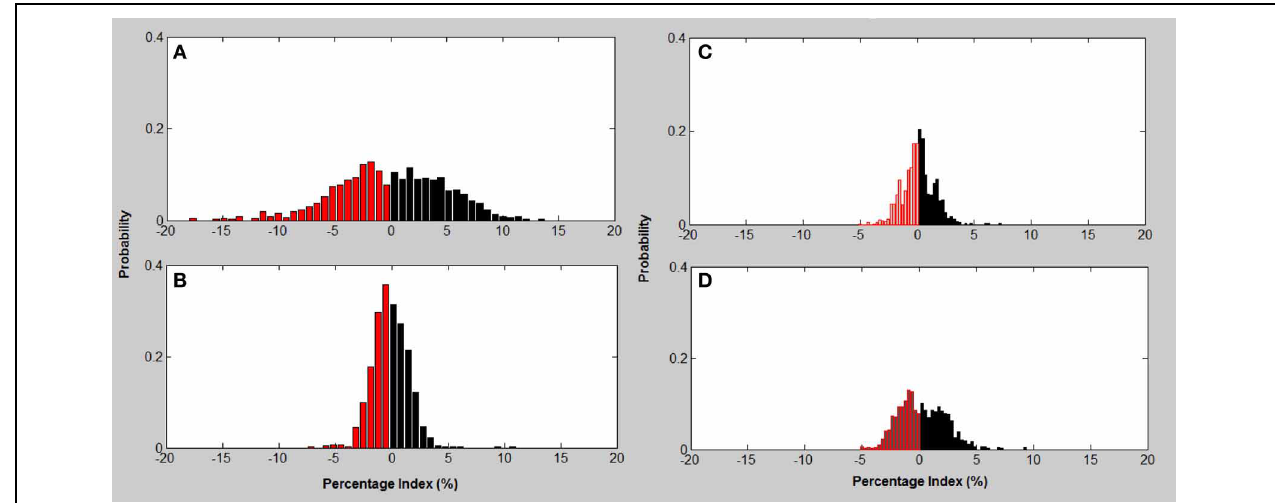
FIGURE 4 | Excitation—inhibition histograms associated with CVD risk category. (A) mild; (B) moderate; (C) high; (D) very high risk; Excitation (black bars)—inhibition (red bars) histograms associated with CVD risk